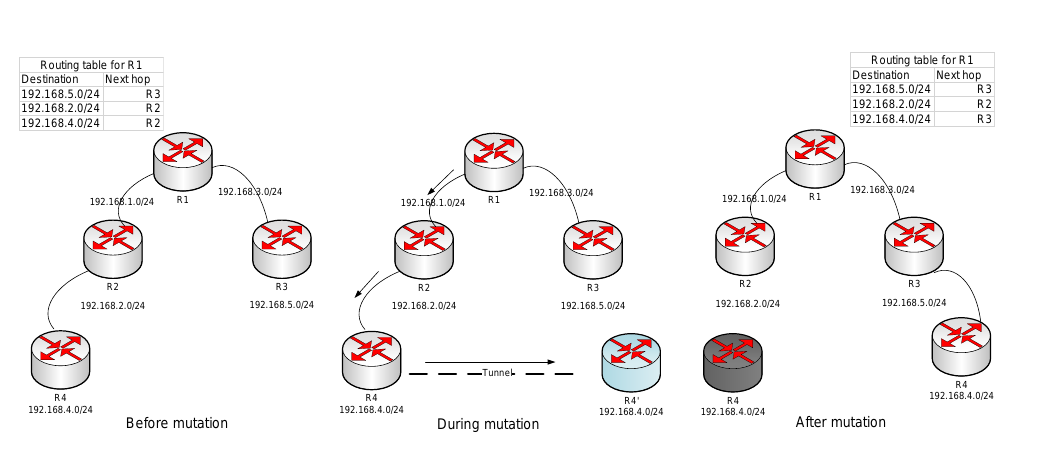
Figure 4. Network Topology Mutation